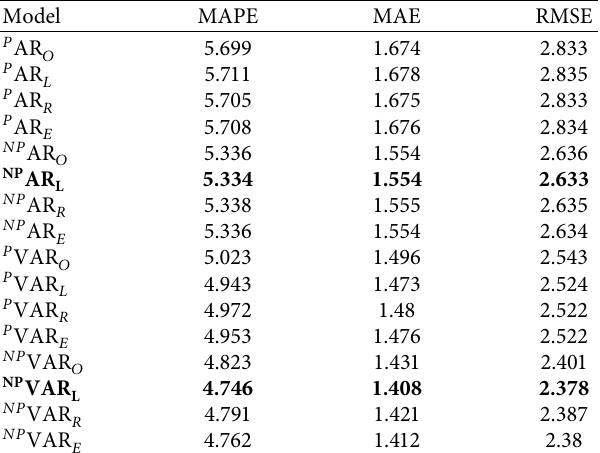
Table 2: Nord Pool electricity prices: one-day-ahead out-of-sample forecasting